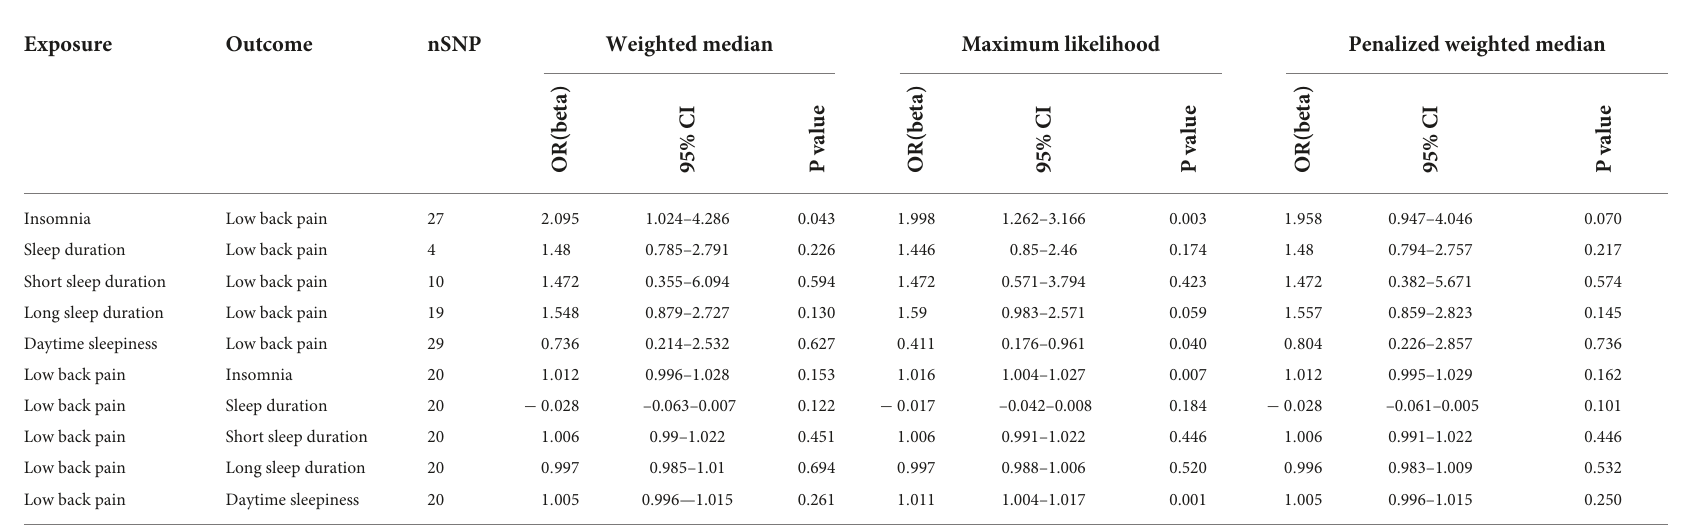
TABLE 1 Bidirectional MR analysis of casual effects between sleep traits and low back pain.